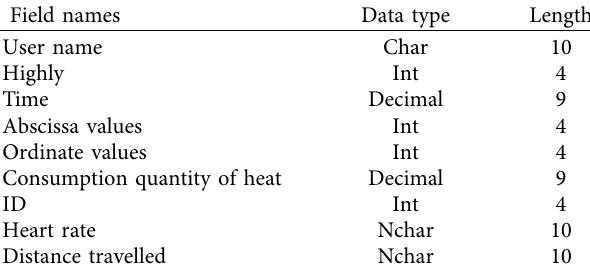
Table 2: User movement record table.